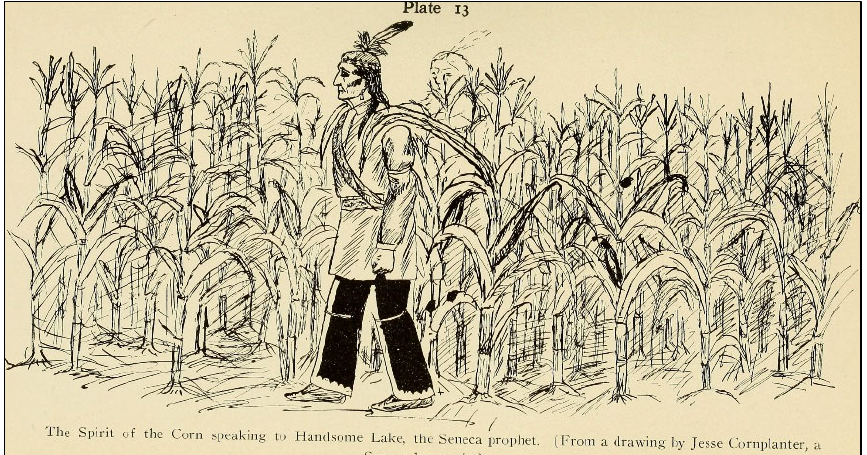
Figure 2. Skanyatali·yó Approached by the Corn